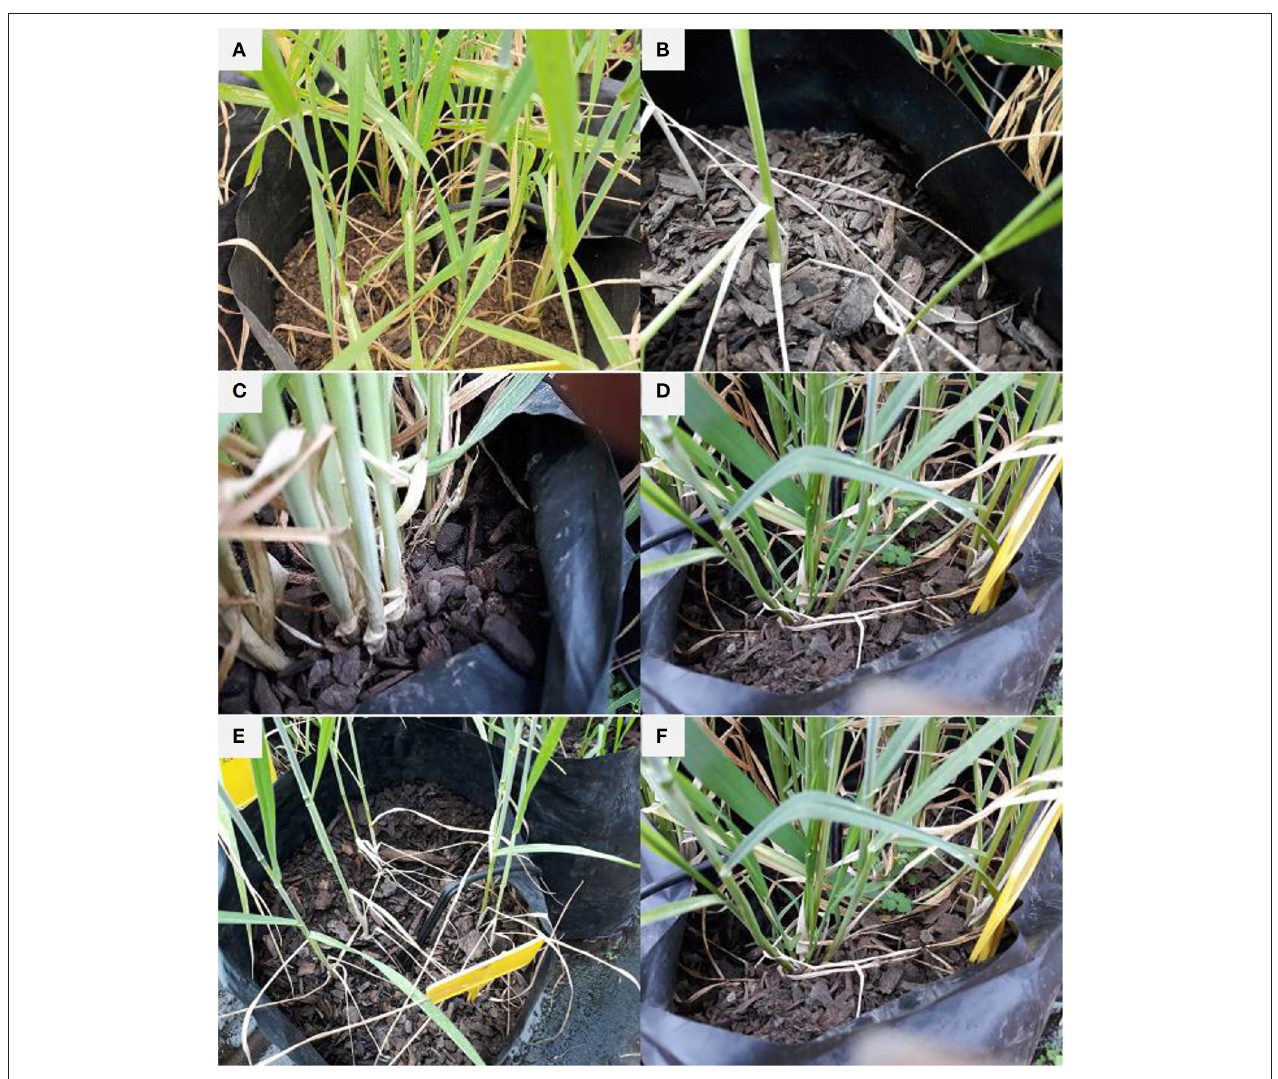
FIGURE 7 | Differences in tiller formation in wheat mutants during the M 3 generation (A–F) at the controlled environment facility. (A,B) (Population 1), (C,D) (Population 2), and (E,F) (Population